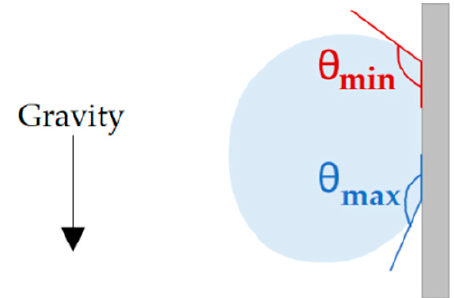
Figure 5. Schematic illustrating the measurement of θ max − θ min when the surface is tilted at 90 ◦ of inclination and the droplet is still